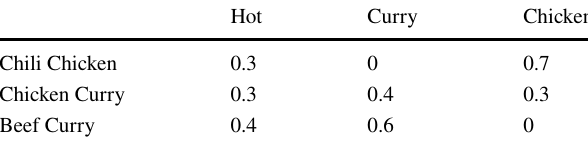
Table 2 Example of probabilistic qualitative